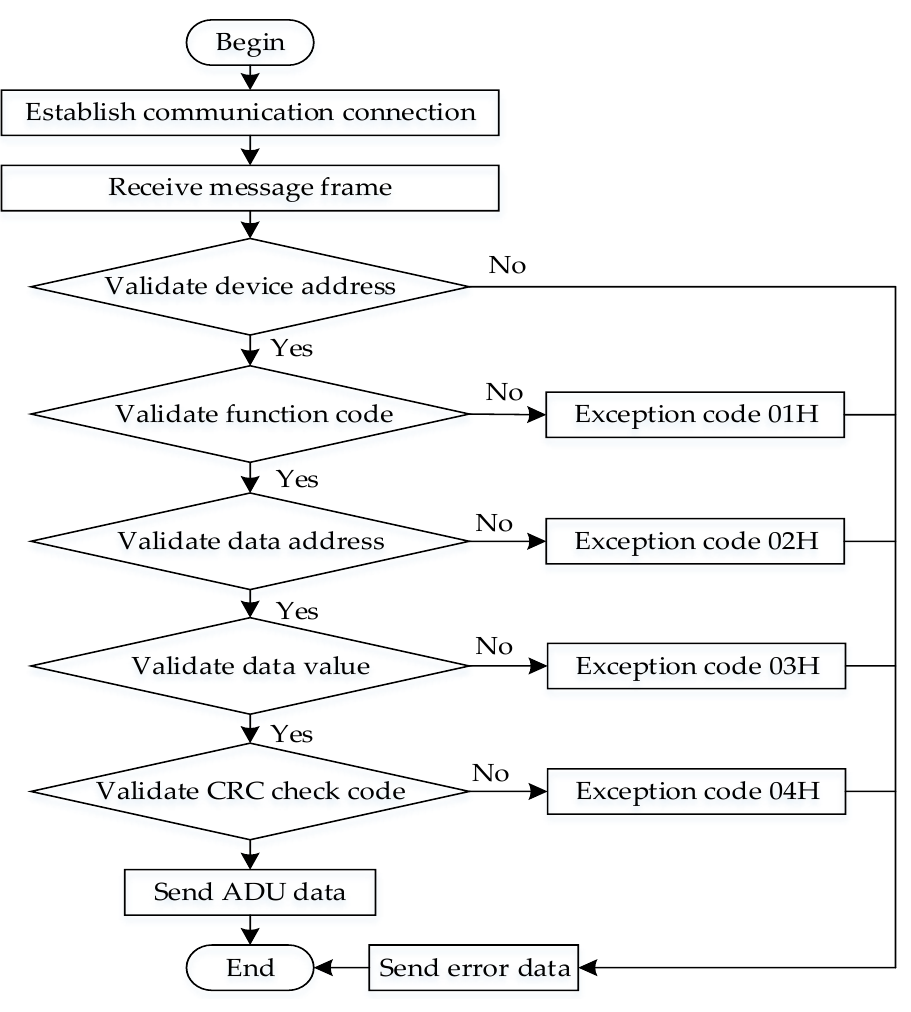
Figure 5. The judgment process of Modbus RTU data.